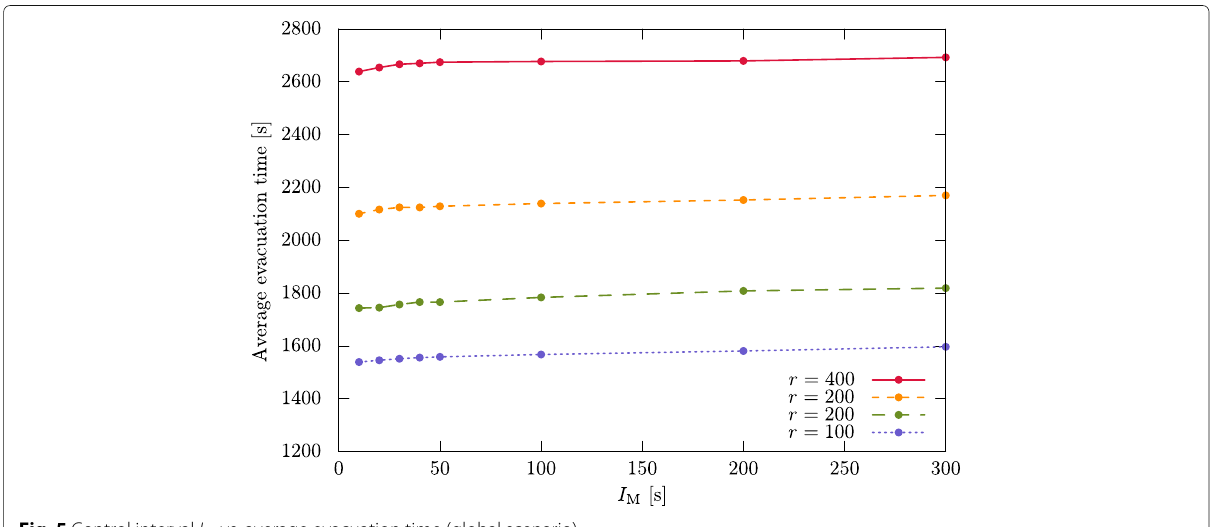
Fig. 5 Control interval I M vs. average evacuation time (global scenario)